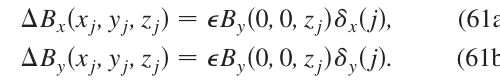
FIG. 16. The kernel k m (cid:1) 1 =I 0 case m ¼ 1 and R ¼ 2 cm .